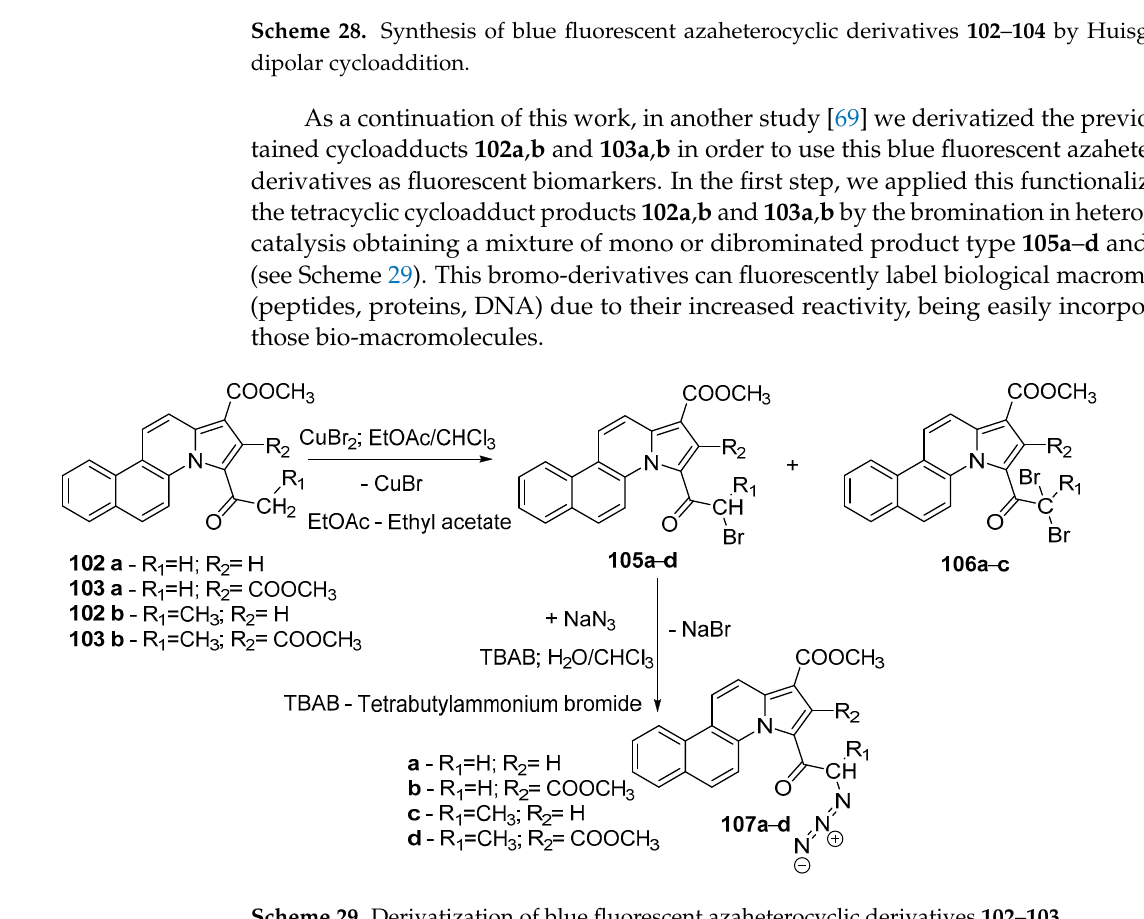
Table 18. λ max (nm) of absorption spectra, λ max (nm) of emission spectra and fluorescence quantum yield (%) of compounds 105a – d and 107a – d